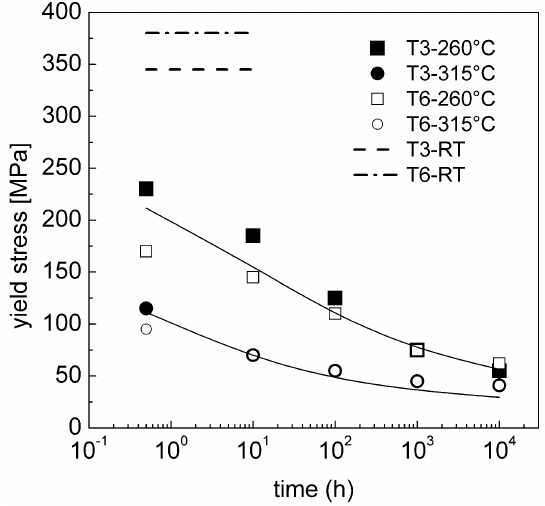
Figure 5. Calculated variation of the yield stress for AA2024 T6 at 260 and 315 °C, after different durations of annealing at these temperatures; the symbols represent the experimental data from Reference [36] for the T3 and T6 states Initial rod diameter 3.4 nm, volume fraction of the intragranular S-phase 0.9% at 250°C and 0.6% at 315 °C respectively. The figure also reports the yield strength at room temperature for the T3 and T6 states [36].